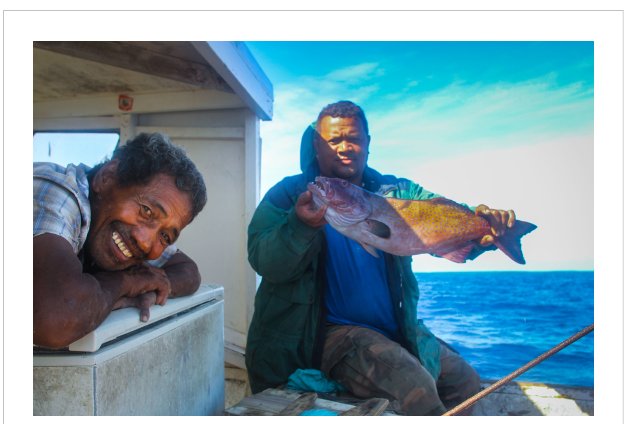
FIGURE 5 Small-scale fi shers from the Lofanga Special Management Area in the Ha ’ apai island group of Tonga. Photographer: Patrick Smallhorn-West.